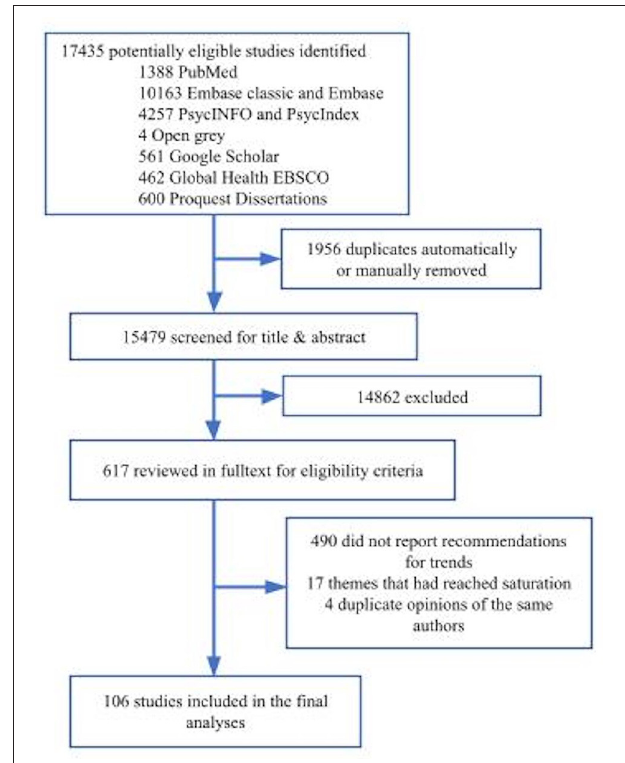
FIGURE 1 | Flow diagram according to the preferred reporting items for systematic reviews and